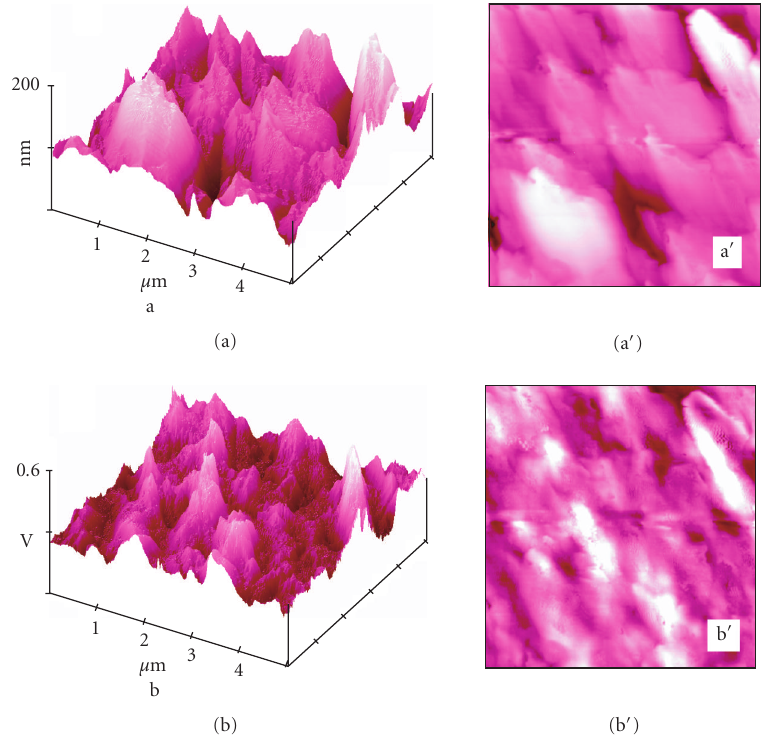
Figure 33: Shear-force AFM (a), (a (cid:3) ) and apertureless SNOM (b), (b (cid:3) ) of a glossy glazed paper showing roughness and distribution of high, medium, and low optical